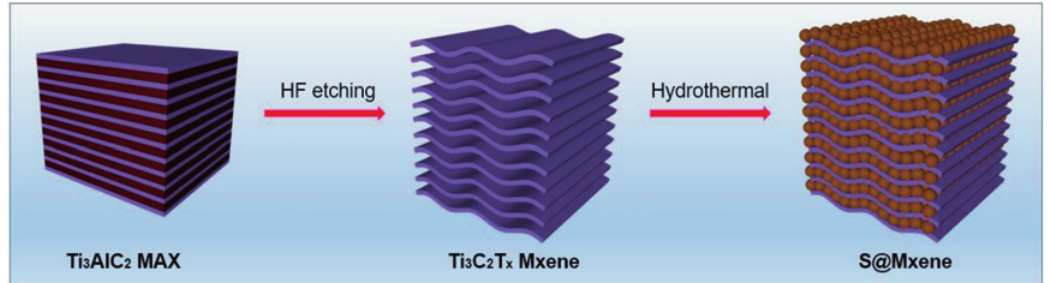
Figure 1: The schematic of preparation of S@ Mxene